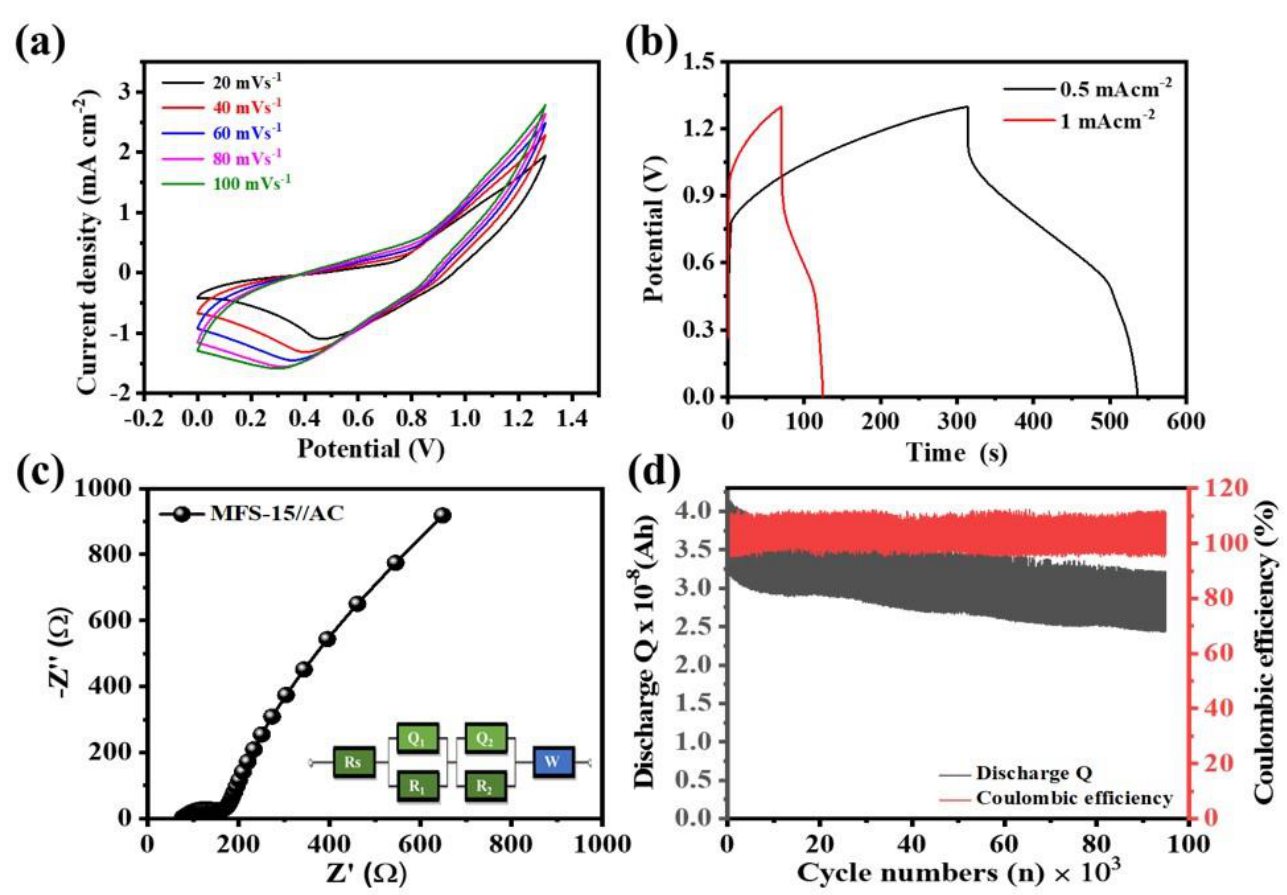
Figure 6. Asymmetric coin cell device of MFS-15 and AC electrode in 3M KOH electrolyte ( a ) CV at different scan rates (20 – 100 mV s − 1 ), ( b ) GCD at different current densities (0.5 – 1 mA cm − 2 ), ( c ) EIS at 10 mV potential within 10 5 – 0.1 Hz frequency range, and ( d ) cyclic stability and coulombic efficiency measured up to 95,000 cycles based on discharge